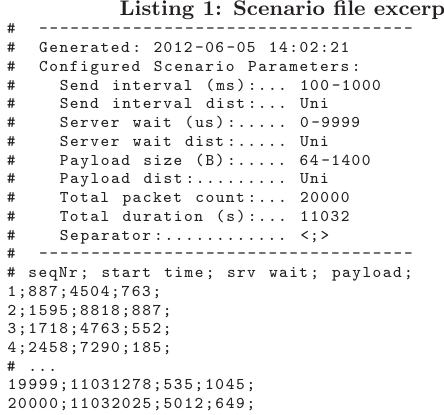
Figure 3: RDM server-based randomness re- generation and timestamping when using ICMP as